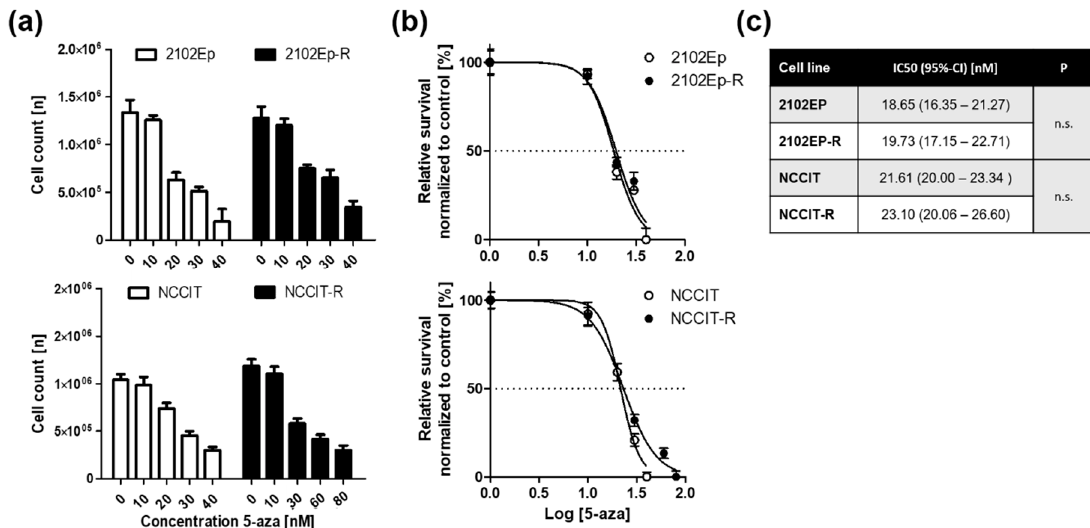
Figure 1. Embryonal carcinoma (EC) cell lines are very sensitive to nanomolar doses of 5-aza. 5-aza was added at the indicated concentrations over a 72 h-period and replenished each day. Viable cells were assessed by trypan blue exclusion method. Means of three identical experiments are displayed. Each experiment was conducted at least three times with similar results. ( a ) Absolute cell counts. ( b ) Normalized inhibitory response curve to 5-aza. ( c ) IC 50 values calculated by non-linear regression analysis.